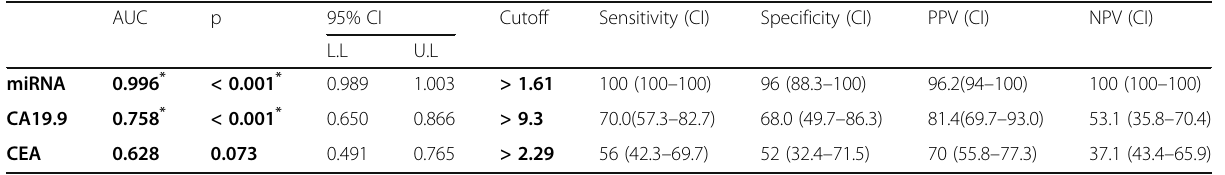
Table 5 Agreement (sensitivity, specificity) to predict patients vs control